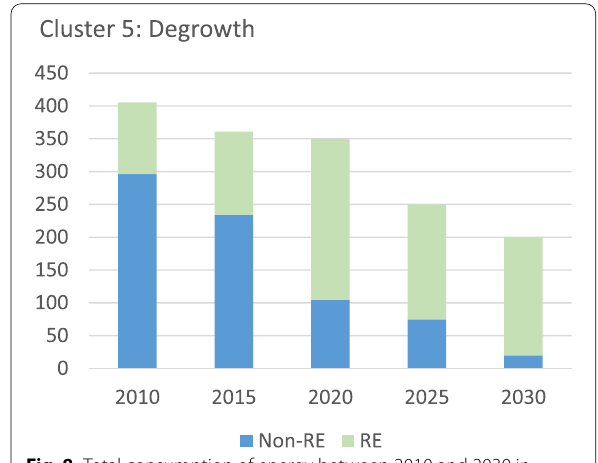
Fig. 8 Total consumption of energy between 2010 and 2030 in ‘degrowth’ scenario (N.B. the total consumption was 378 TWh in 2019; 2010 and 2015 have been added